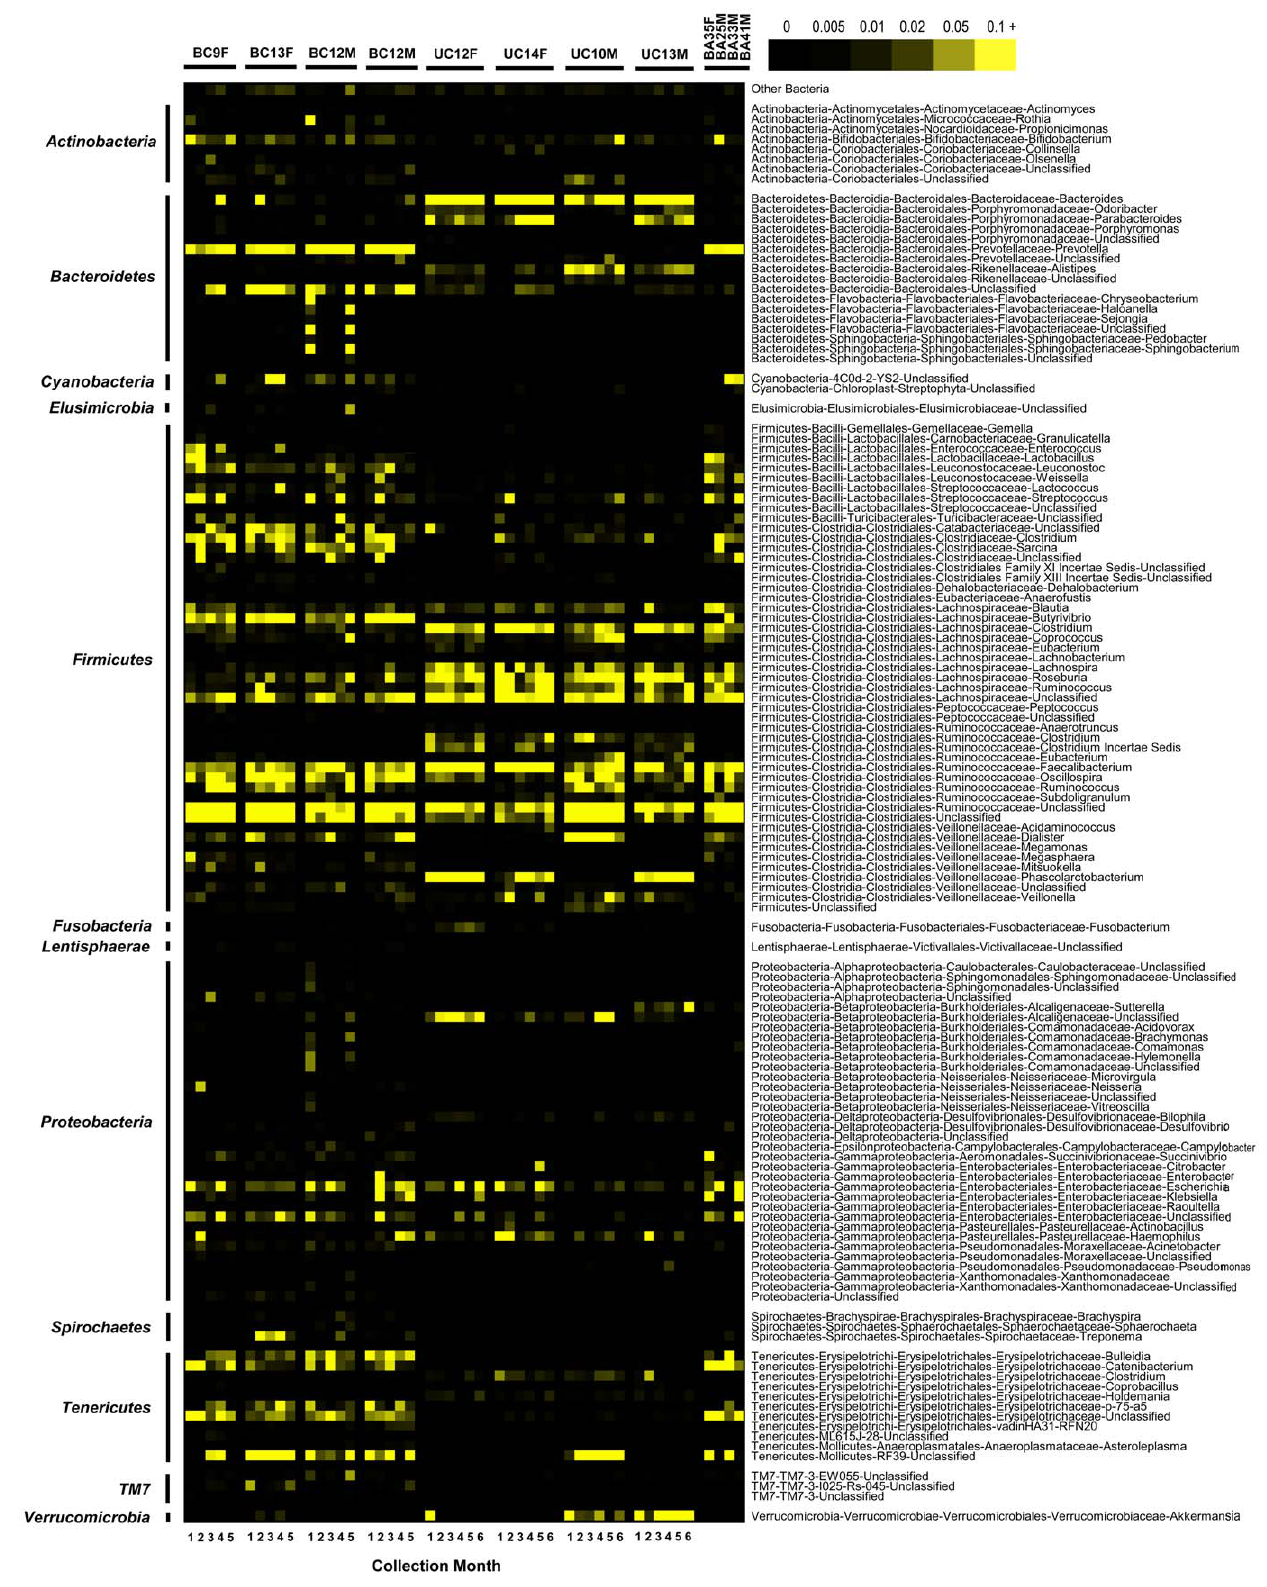
Figure 6. Heat map of the relative abundance of genera found in the V1–V3 16S rDNA sequence data. Data from U.S children, Bangladeshi children, and Bangladeshi adults were rarefied to the same number of reads per sample to normalize for the unequal sampling effort. Only genera with a total normalized abundance of at least ten reads are displayed. Color intensity is proportional to the relative abundance of the taxon and is represented by the scale (black, 0% present; yellow, $ 10% present). doi:10.1371/journal.pone.0053838.g006 PLOS ONE | www.plosone.org